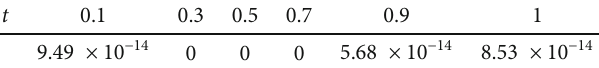
Table 6: The MAEs of Example 7 for M = 2 .